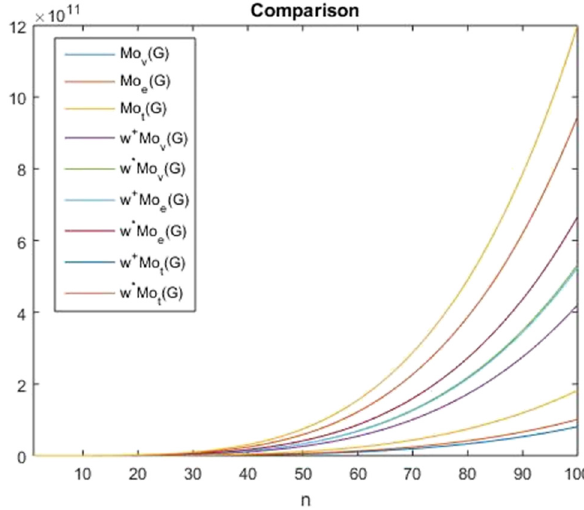
Figure 4: 2D plot for Theorem